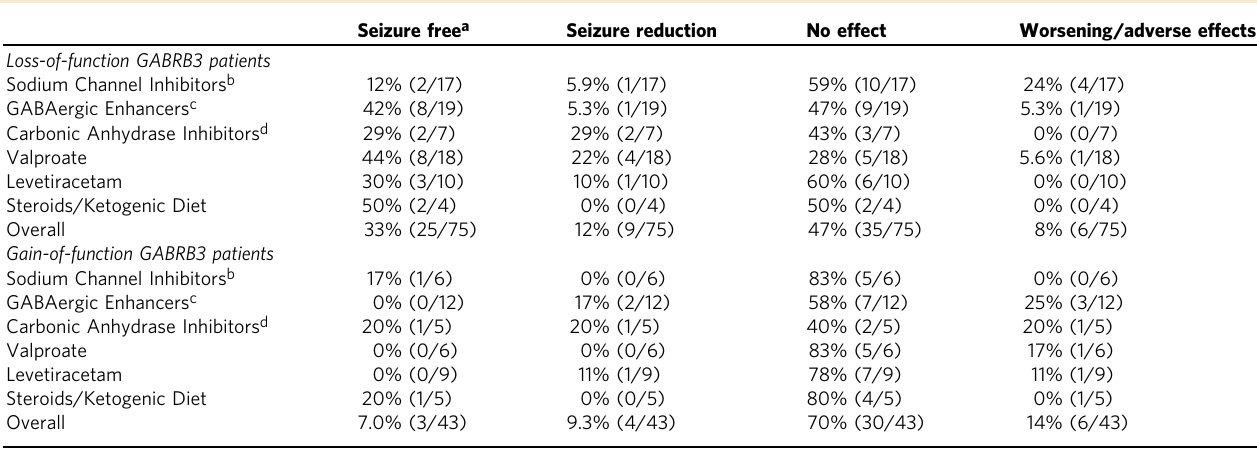
Fig. 5 Representative electroencepholagram from patients harbouring a GOF or LOF variant. Interictal EEG showed a disorganized background activity with intermixed 12 – 15Hz component (blue boxes) and multifocal epileptiform abnormalities (red circles) in patients with gain-of-function variants and normal/slightly delayed background activity, with generalized high amplitude 3 – 4Hz activity/spike and slow waves (dotted lines) in patients with loss-of-function Table 1 Drug responses in patients with loss- and gain-of-function GABRB3 variants.